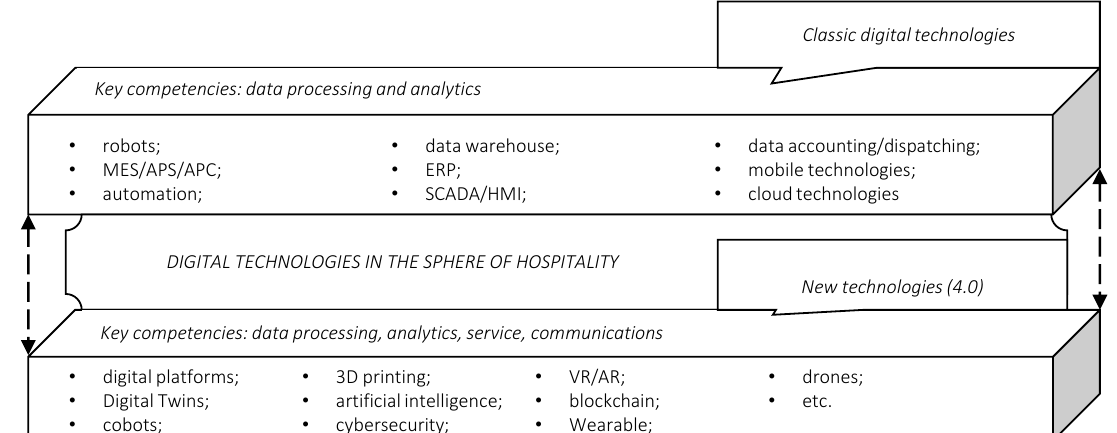
Key competencies: data processing and